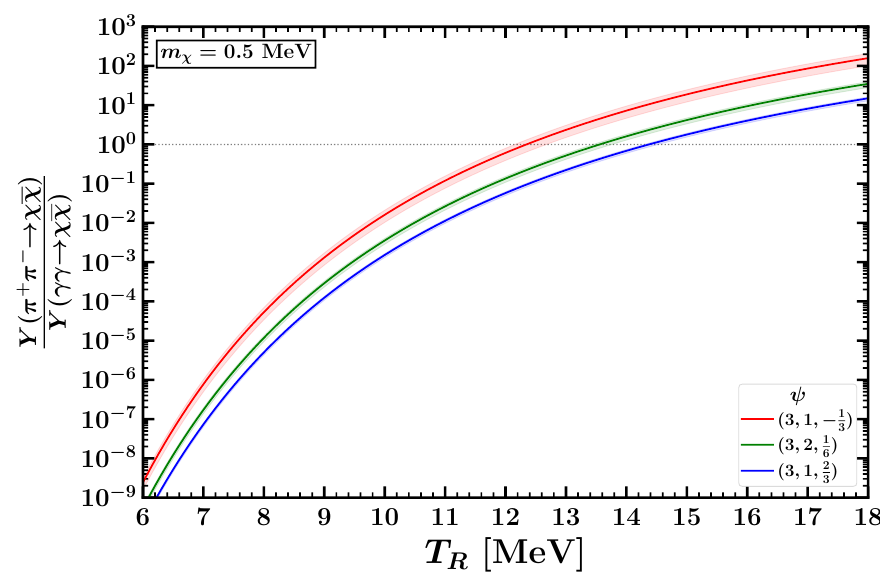
Figure 1 . The ratio of dark matter produced from pions to dark matter from photons as a function of the reheating temperature for m χ = 0 . 5 MeV. Different curves correspond to different representations of ψ under the SM gauge group ( SU (3) c , SU (2) L , U (1) Y ) . The quark doublet-like representation on which we focus in the main text is shown in